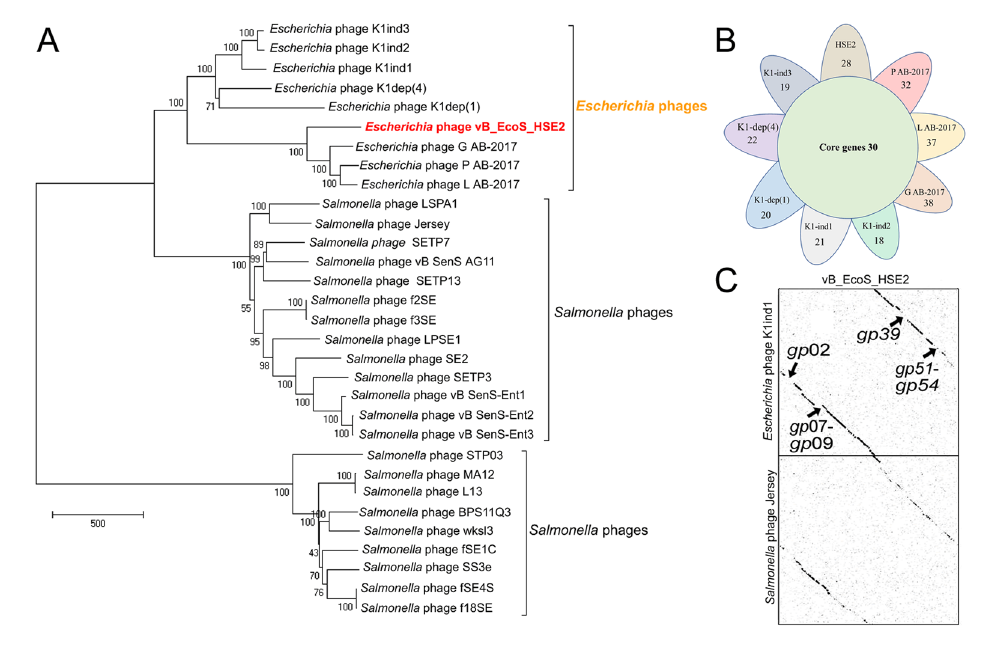
Figure 6. Phylogenetic and comparative genomic analysis of the phage vB_EcoS_HSE2. ( A ) Phylogenetic analysis of phages that showed similarity with the phage vB_EcoS_HSE2. The phage genomes that showed similarity higher than 20% with the genome of phage vB_EcoS_HSE2 were collected and used for phylogenetic tree construction. ( B ) Core-genome analysis of phages from the same evolutionary branch with phage vB_ EcoS_HSE2. The numbers of core genes for the 9 phages were indicated in the central circle, and the number of specific genes were also shown. ( C ) Dot plot analysis of phage vB_EcoS_HSE2 with phage K1ind1 and Jersery. The genes that were absent in phage K1ind1 genome are